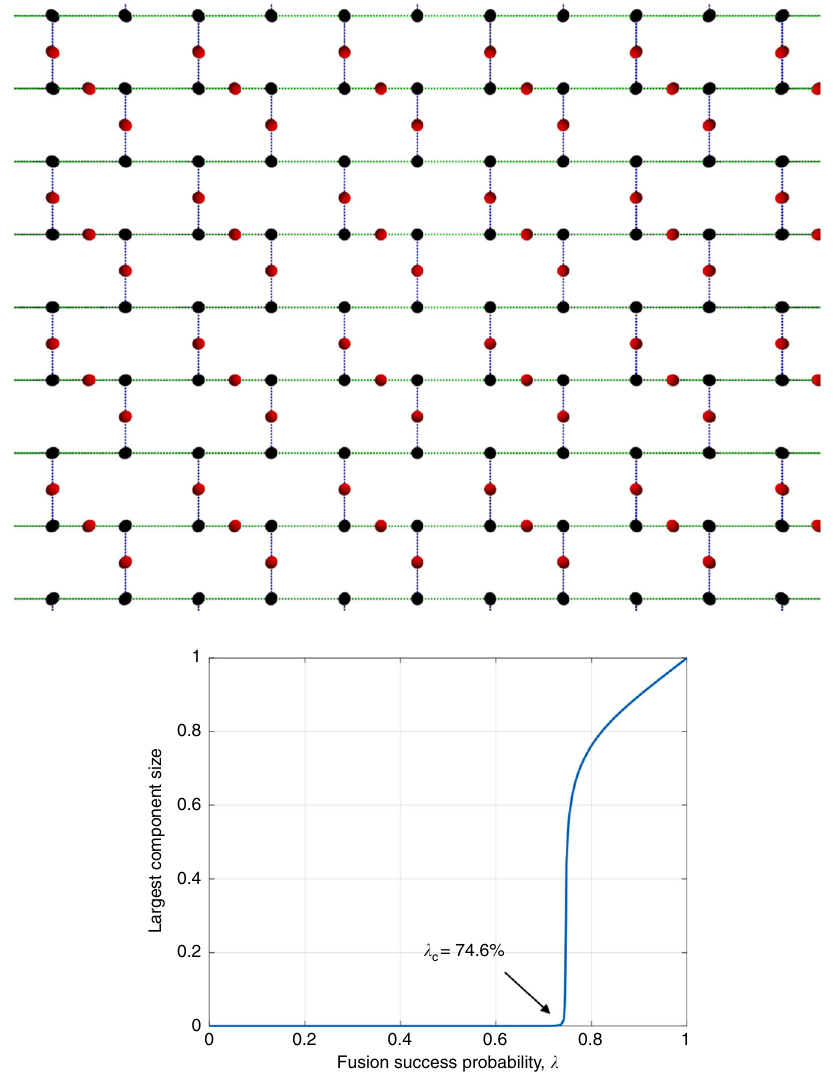
Fig. 8 Bond percolation on the modi fi ed 2D brickwork lattice. This 2D lattice has a bond-percolation threshold of 0.746, which is less than the fusion success probability achievable with single-photon boosting. This shows that single-photon-boosted linear optical fusion and three-photon GHZ- state clusters are suf fi cient to generate a universal lattice ballistically by fusing the clusters on a two-dimensional